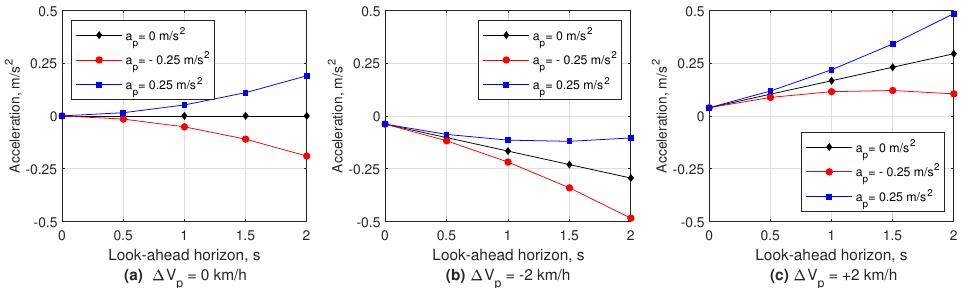
Figure 2. Acceleration characteristics of La-ACC for varying look-ahead horizon at different speeds and accelerating conditions of the preceding vehicle. The object vehicle is at 80 km/h speed with a gap of 30 m from the preceding